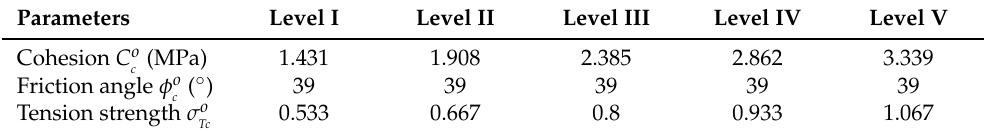
Table 3. Mechanical properties of graded